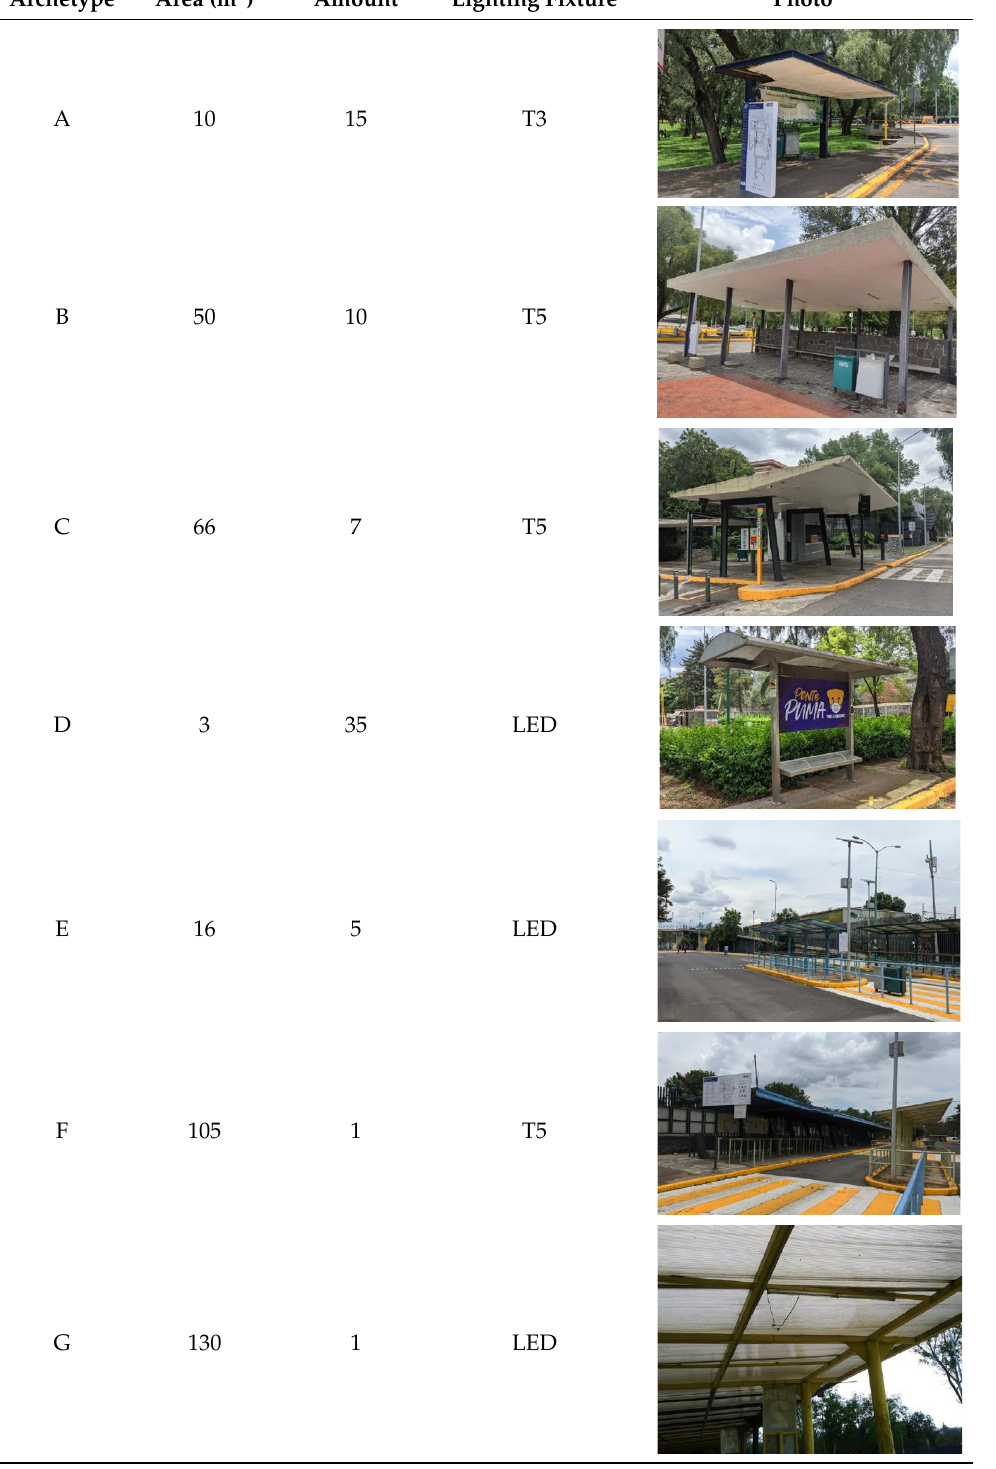
Table 3. Energy demand scenarios for the campus bus stations. Archetype Station